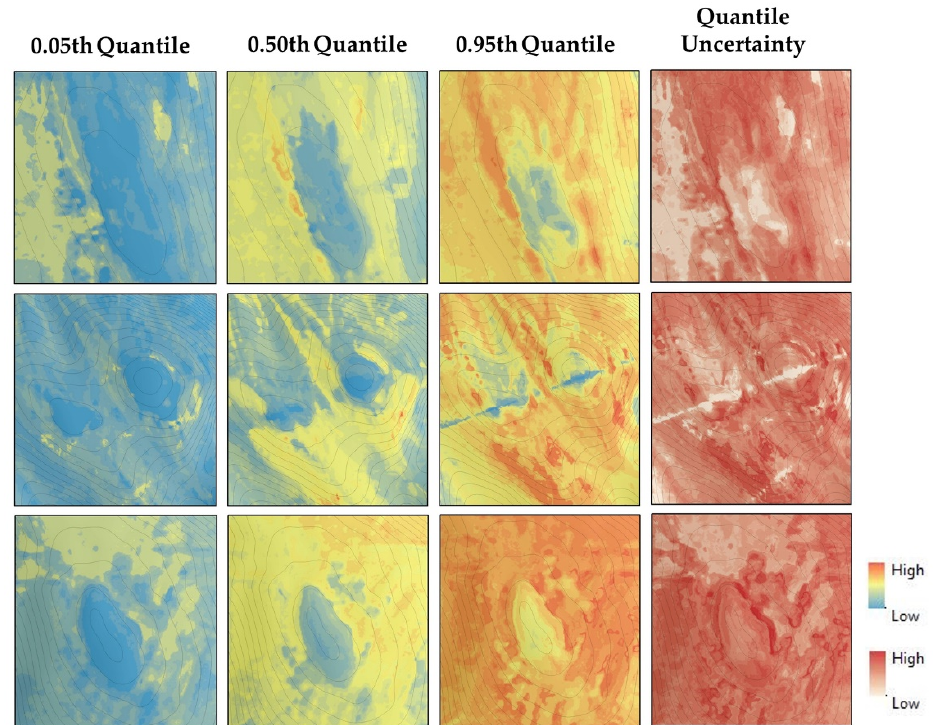
Figure 9. Enlarged maps of the PMN abundance prediction from three areas with black patches (no nodules). From left to right are the 0.05th, 0.50th, and 0.95th quantiles shown, followed by the quantile uncertainty. The superimposed bathymetric contours have a 1 m depth interval.